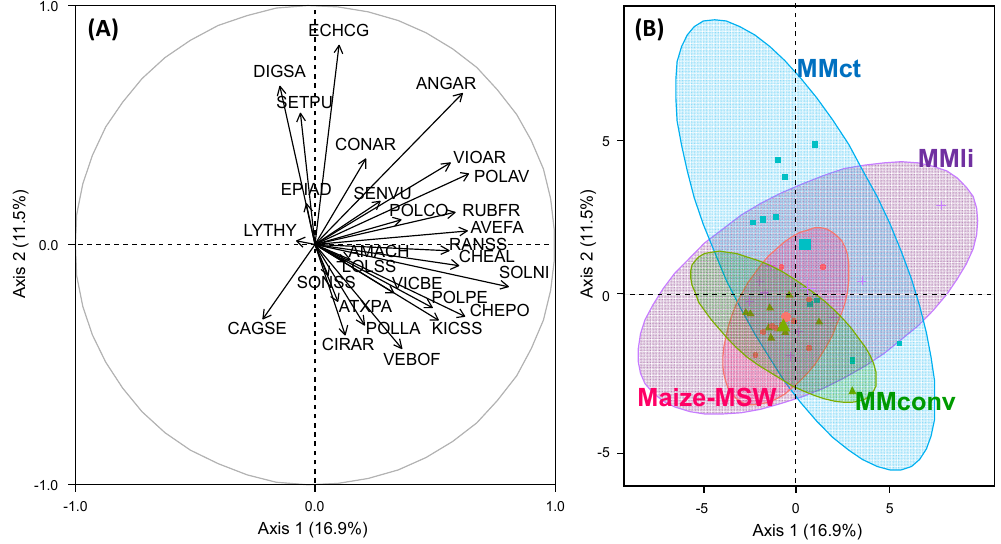
Figure 1. ( A ) Correlation circle with the first two axes of principal component analysis (PCA) performed for the matrix of plots ( N = 40, i.e., four cropping systems replicated twice over 5 years) and weed species ( N = 28, described by the “Potential of Infestation” indicator). Weed species are indicated by their EPPO codes (http://eppt.eppo.org). Table S2 details the correspondance between the EPPO code and the species name. ( B ) Scatter diagram with the first two axes of the PCA. Ellipses represent a 95% confidence interval for each cropping system (MM Conv : conventional maize monoculture; MM CT : conservation tillage maize monoculture; MM LI : low-input maize monoculture; Maize-MSW: integrated maize rotation).